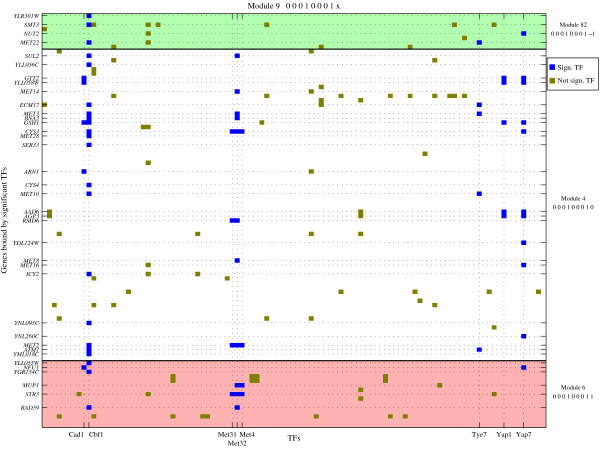
TF-Gene Map for Module 9. The TF-Gene map indicates which genes in the module can be bound (upstream) by the TFs that are significantly related to this module. Only those genes that have a binding motif in their upstream region for one of these significant TFs are annotated along the vertical axis. For these genes a dotted horizontal line is drawn. The significant TFs are annotated along the horizontal axis. For these TFs a dotted vertical line is drawn. This module, which contains all genes upregulated under sulfur limitation irrespective of the oxygen effect, can be subdivided into groups characterized by their response to oxygen presence. Genes at the top of the map (with green background) have a significantly lower expression when grown without the presence of oxygen. This group corresponds to Module 82. The middle part of the map (with white background) displays genes, which are not affected by the presence of oxygen. This group corresponds to Module 4. Genes in the bottom of the map (with red background) have higher expression when grown aerobically. This group corresponds to Module 6.